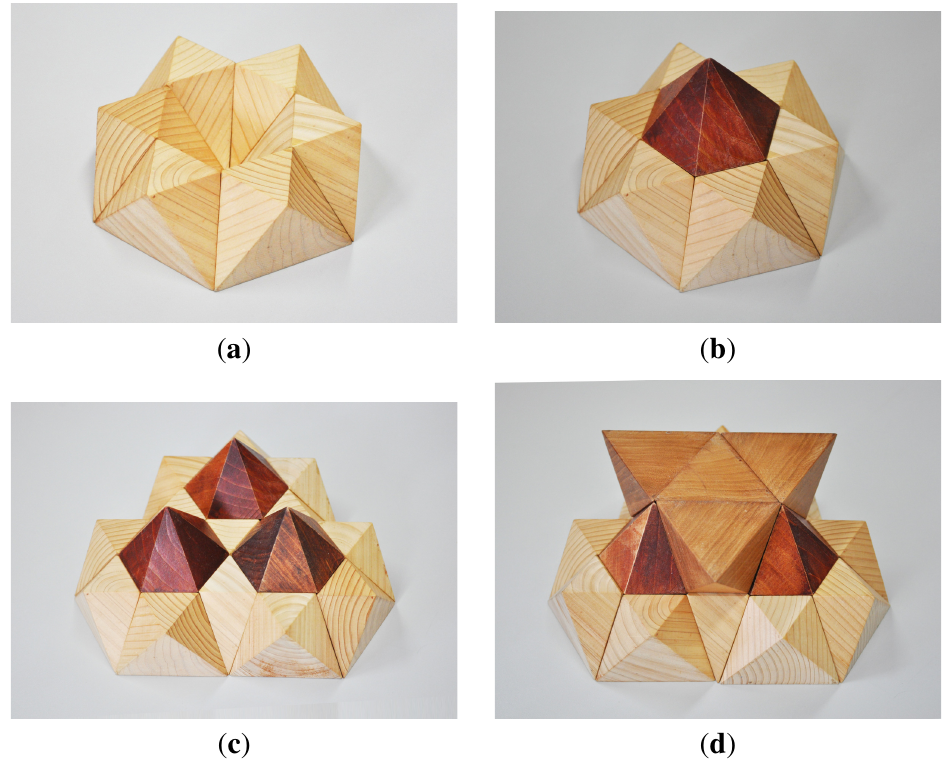
Figure 11. A tiling of the 3D Euclidean space with H and